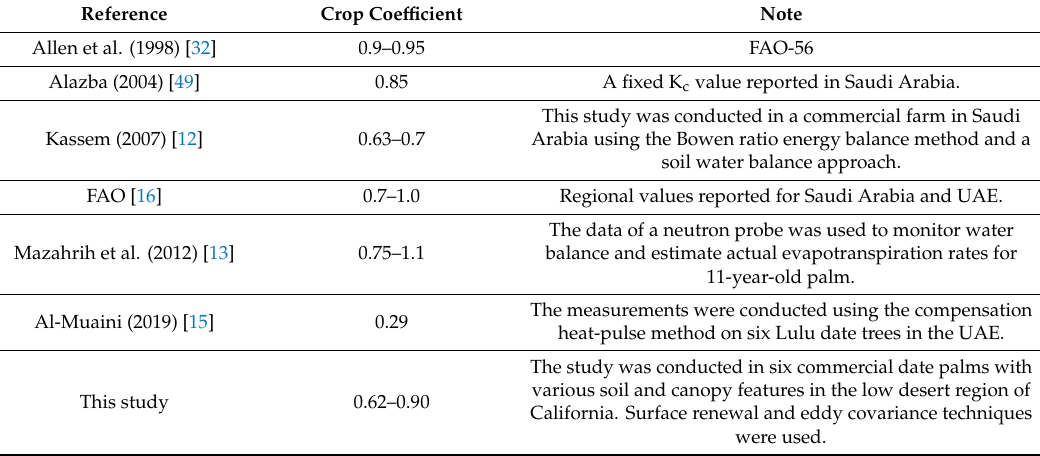
Table 6. Comparison of crop coe ffi cient estimates by this study and the values proposed by other researchers for date